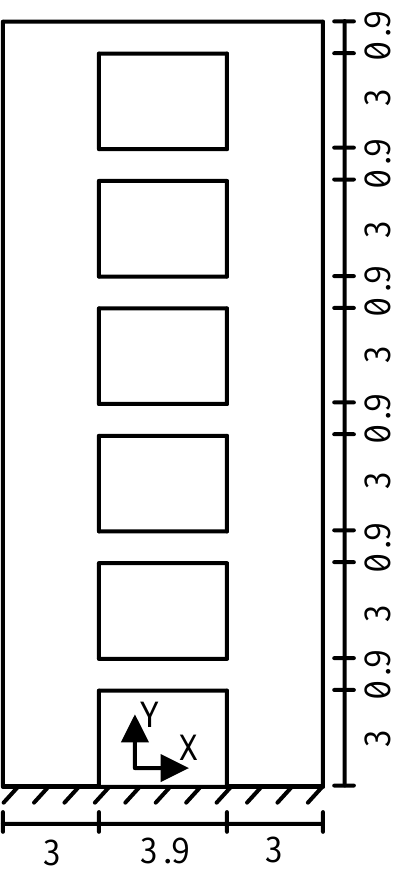
Figure 9. Dimension diagram of shear wall B (unit: m).